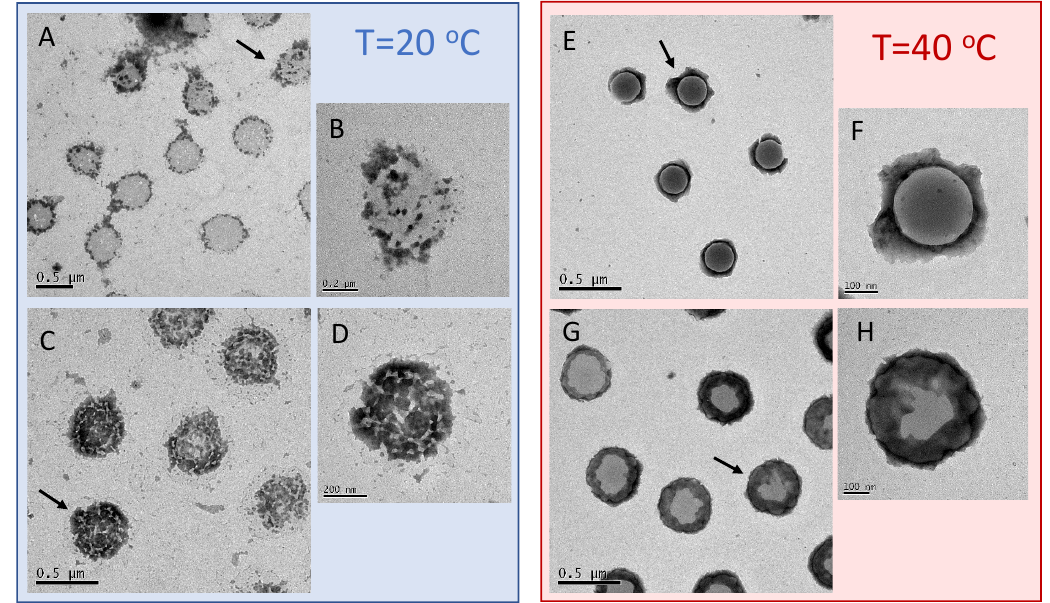
Figure 9. TEM images (PTA staining) of P α 250/m1-KPS complexes formed at C = 0.0015 mg/mL (panels A , B and E , F ) and C = 0.01 mg/mL (panels C , D and G , H ), for T < T c (left block) and T > T c (right block). The interaction between PTA and PLL chains originates the positive staining of polycation-covered microgel and regions covered by P α 250 chains appear as dark halo surrounding or overlaying particles. At T < T c these regions assume an evident patchy-like pattern, while above T c they become more homogeneously distributed around the outer shell of the microgels.